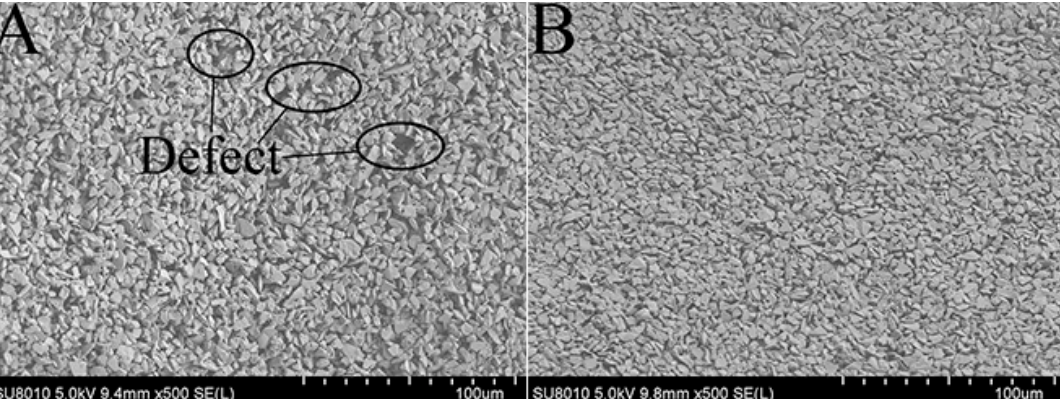
Figure 4. Schematic diagram of coating with different coating methods ( A : one-step coating; B : two-step coating).